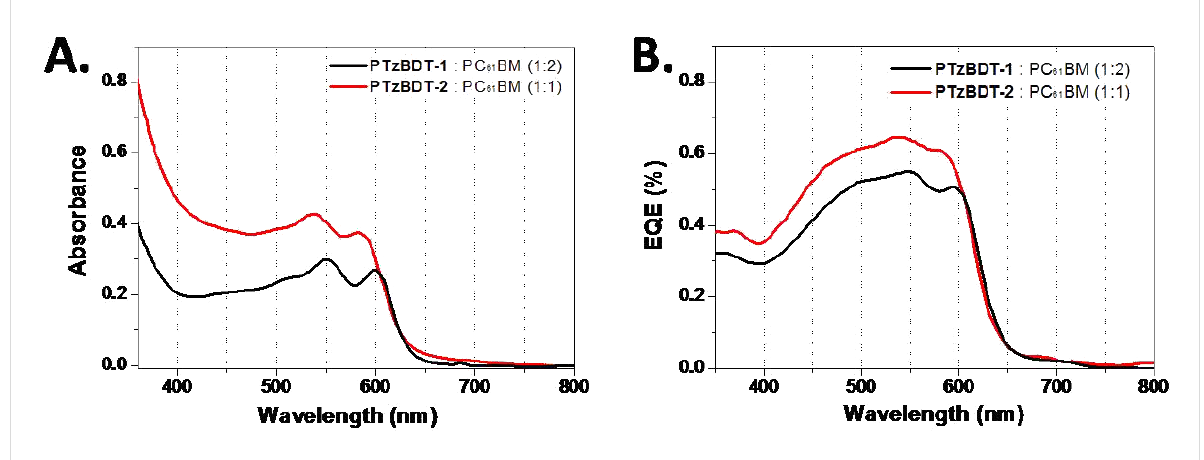
Figure 4: A) UV–vis absorption spectra and, B) EQE plots of optimized PTzBDT-1/PTzBDT-2:PC 61 BM based